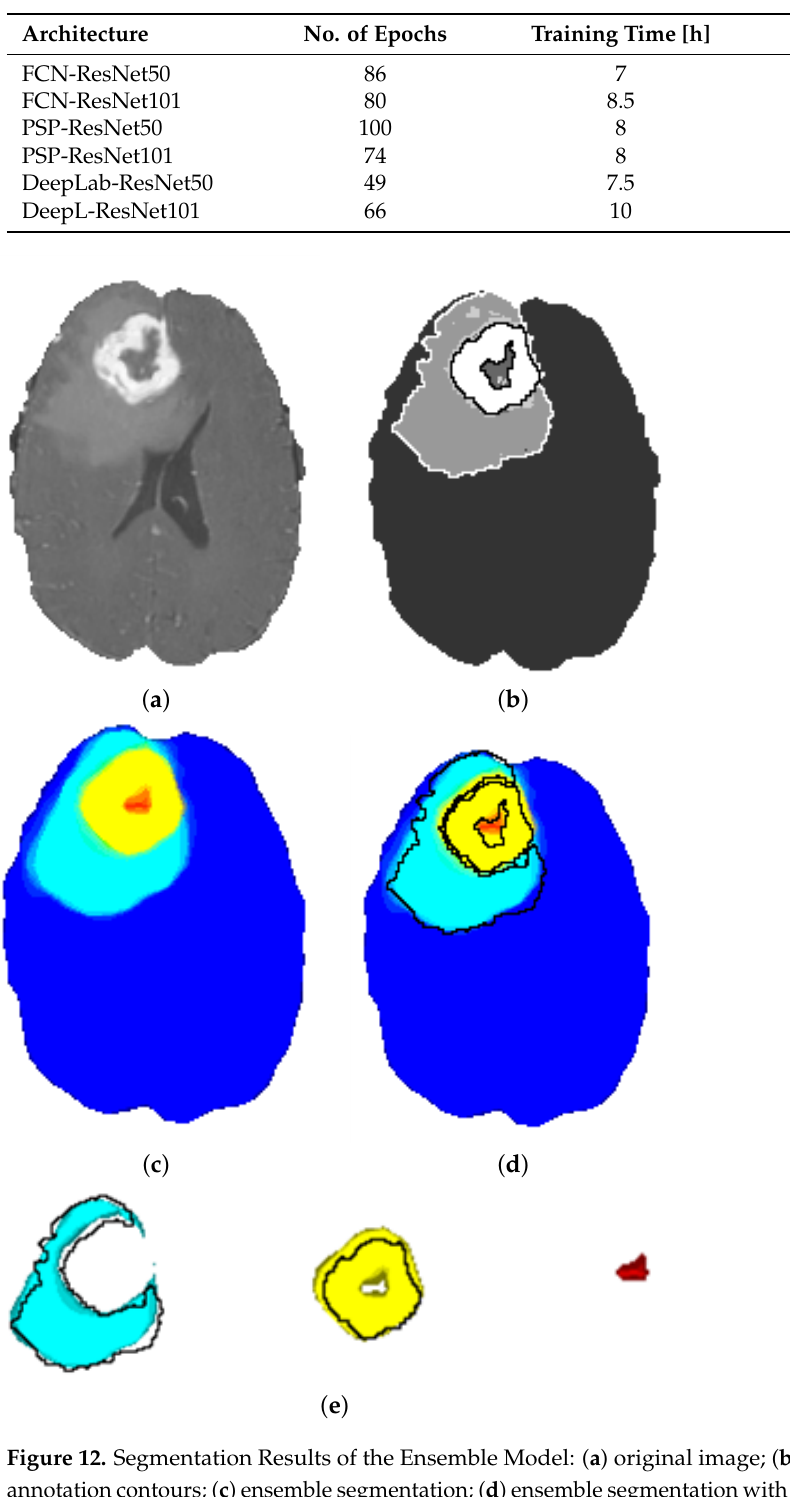
Table 8. Training Time of the 6 Networks.